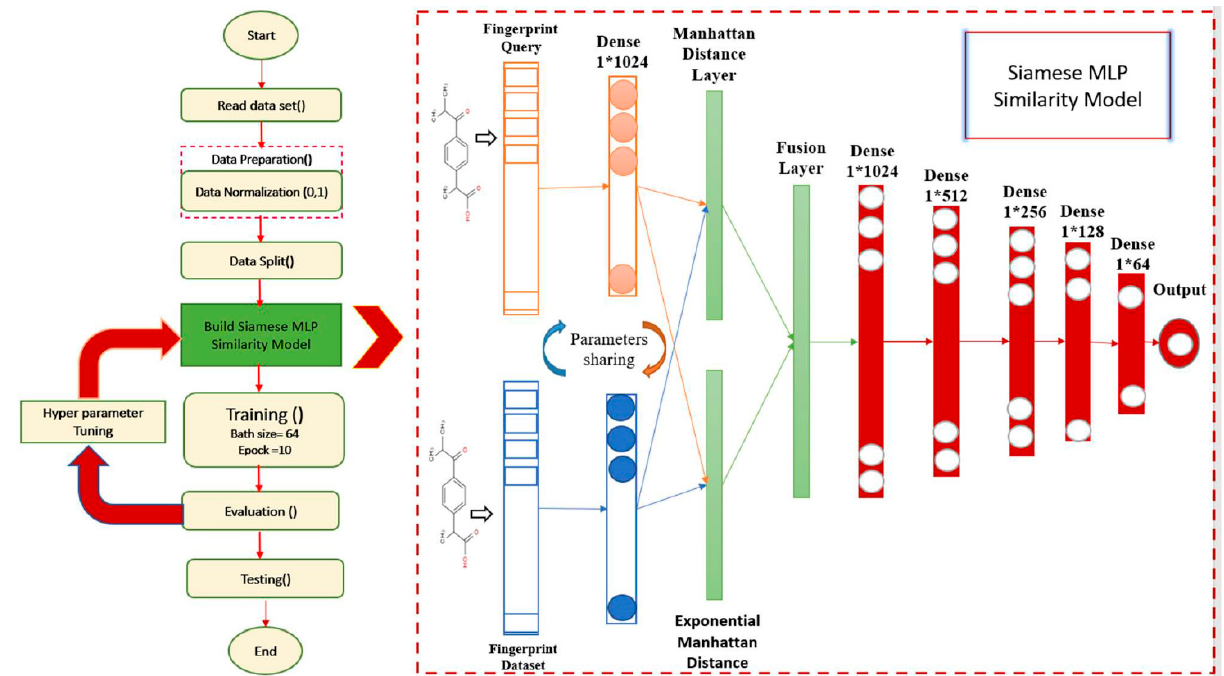
Figure 2. Enhanced Siamese MLP similarity model.